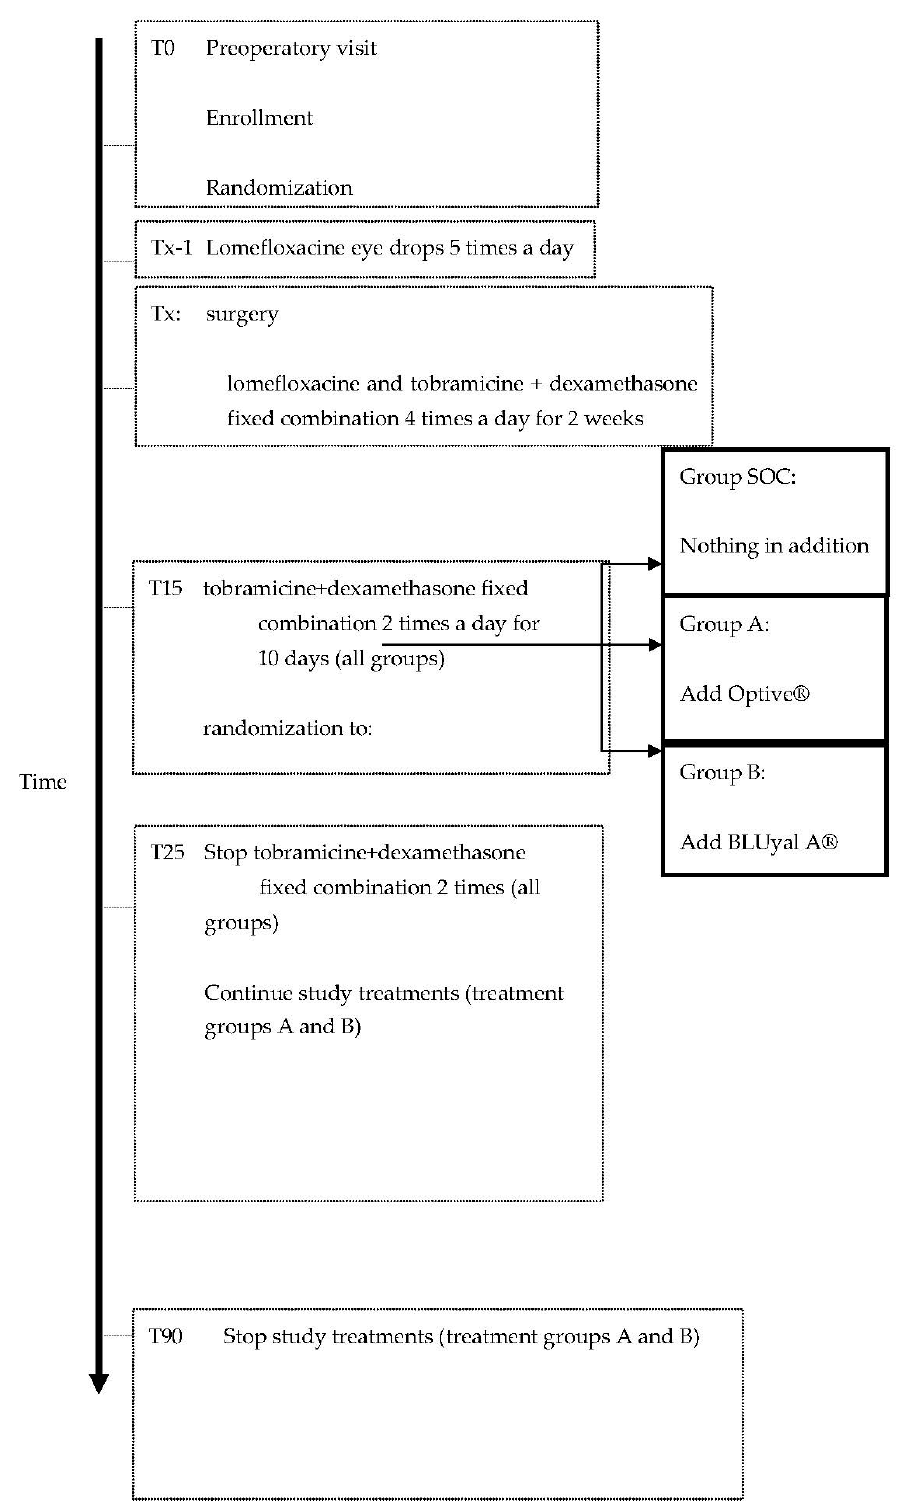
Figure 1. Flow-chart of the study